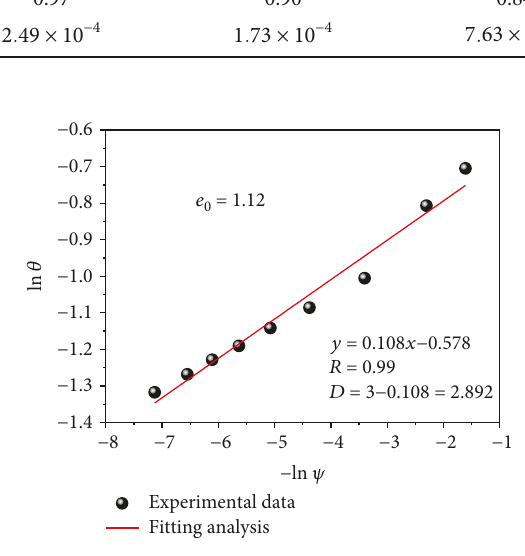
Figure 5: Fractal dimension of Hunan clay.